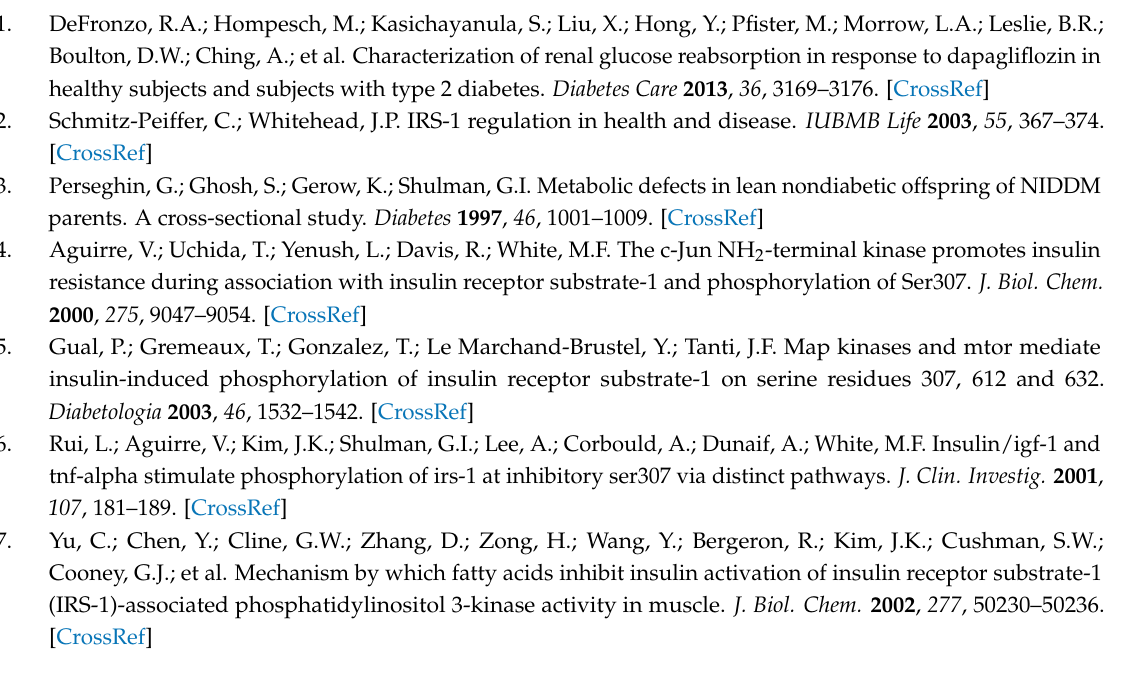
Table S1. Top 20 proteins output from prediction of PharmMapper server; Figure S1. Synthetic route for compound 2 (Alkynyl-GA). Figure S2. The NMR data of Alkynyl-GA. Figure S3. The HRMS data for alkynyl-GA. Figure S4. Synthetic route for Probe 1. Figure S5. Synthetic route for click chemistry product probe2 (compound